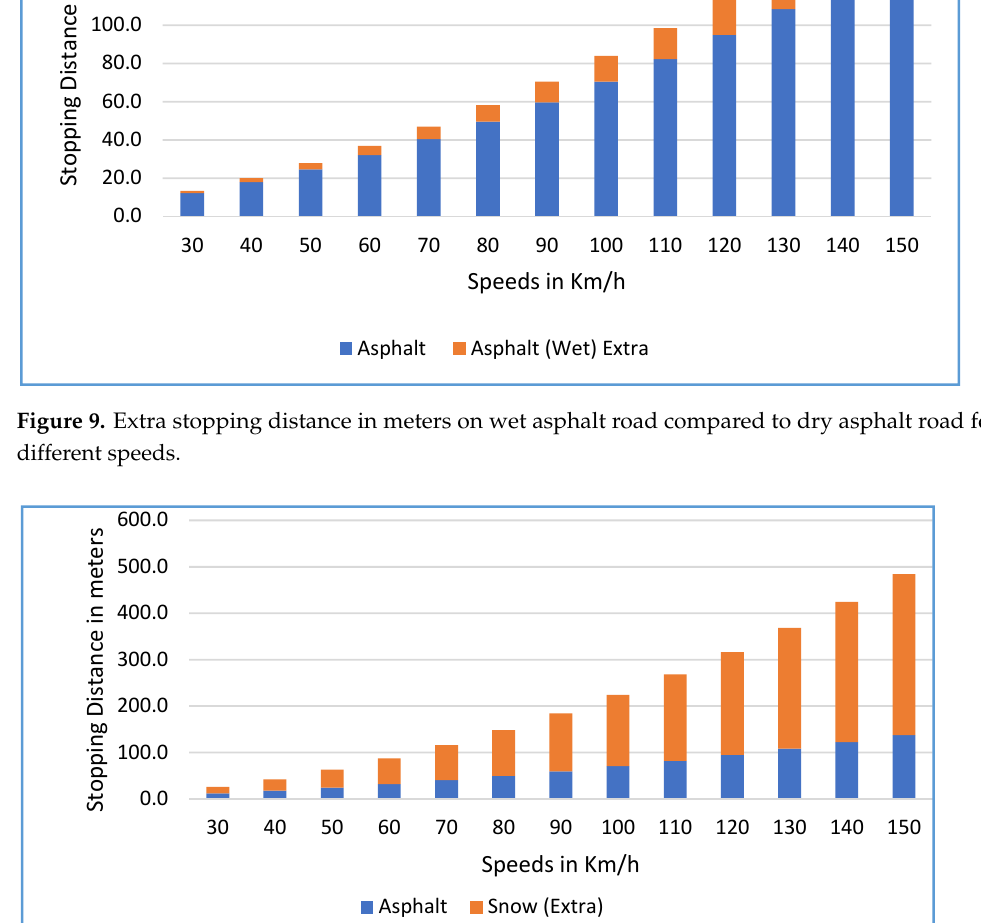
Figure 9. Extra stopping distance in meters on wet asphalt road compared to dry asphalt road for different speeds.